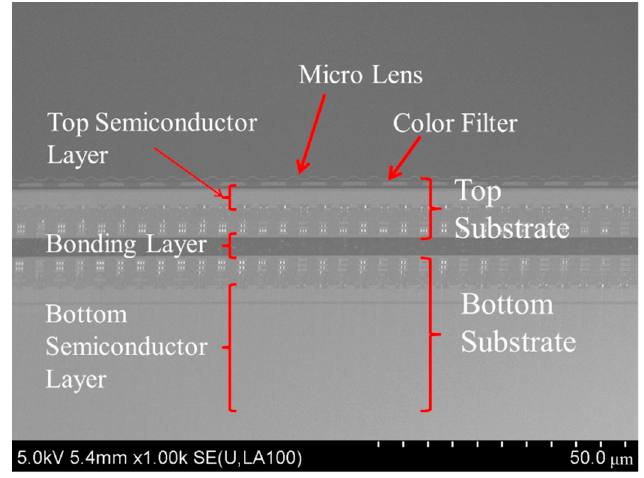
Figure 2. Cross-sectional SEM image of image sensor. Two substrates are bonded, and both have a semiconductor layer. Micro lenses and color filters lie on the top substrate.